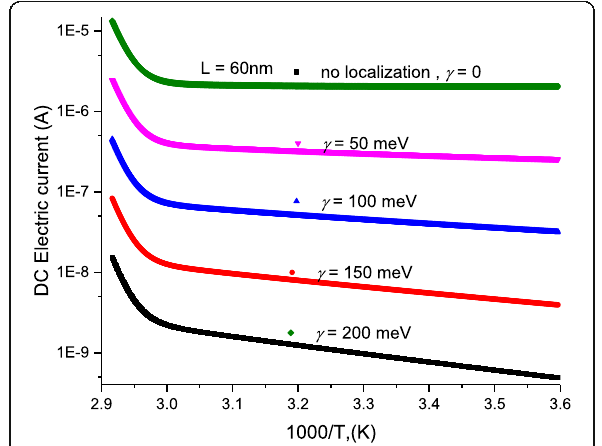
Fig. 8 Variation of the disorder energy γ as a function of temperature for different DNA lengths